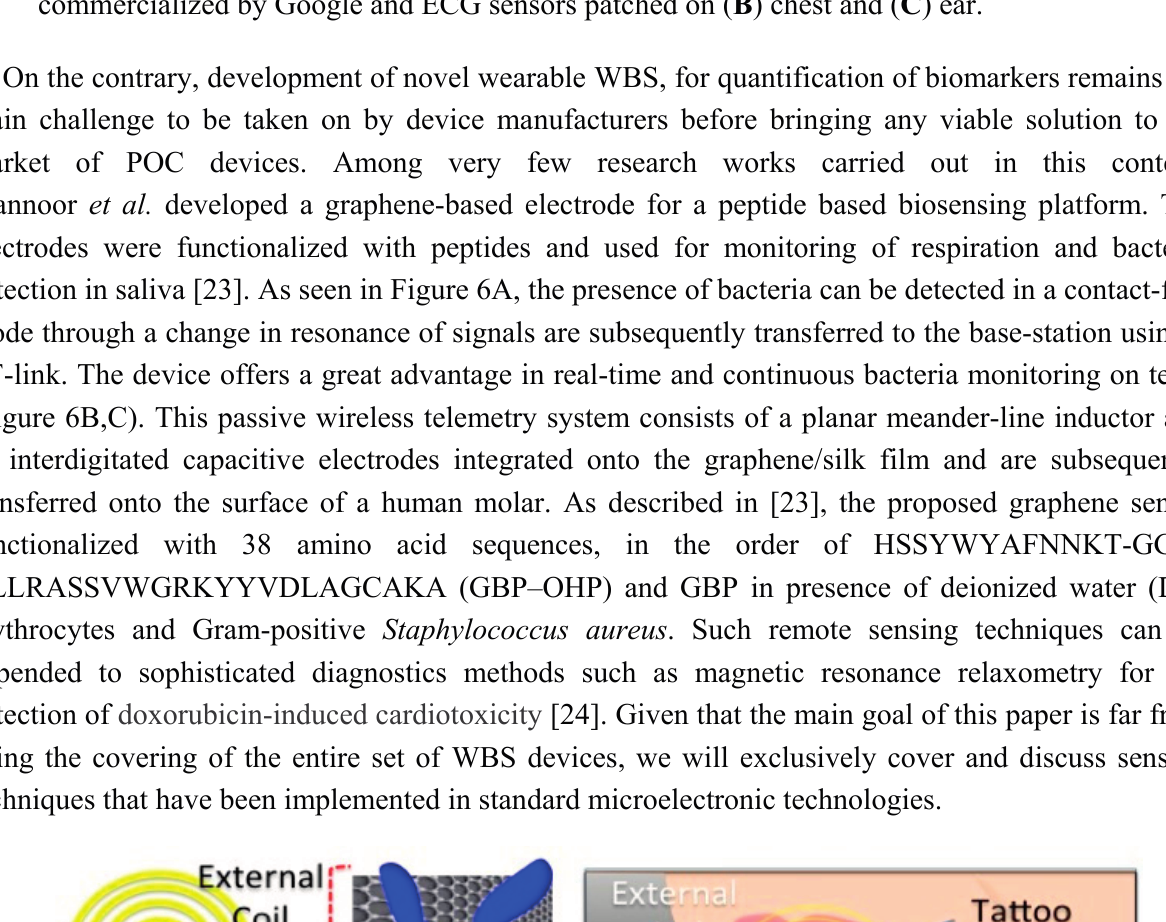
Figure 5. State of art wearable POC devices: schematic of ( A ) contact-lens glucose sensor commercialized by Google and ECG sensors patched on ( B ) chest and ( C ) ear.